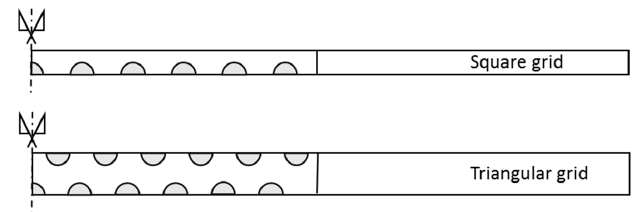
Figure 13. Numerical model of a slice of columns for triangular and square grids.